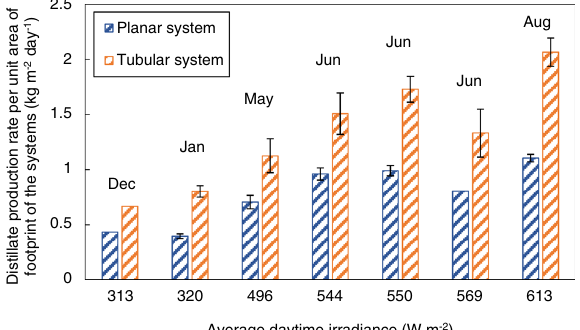
Fig. 4 Distillate production rates of single-stage planar and tubular systems per unit area of footprint under natural sunlight. Both the planar and tubular systems had the same membrane dimensions (i.e., 50 mm × 50 mm), the same volume of distillation chamber, and the same inner surface area of the condensation chamber. The surface density of carbon black NPs on the permeate side of the membrane was 7.5 – 7.9 g m − 2 and the hydrostatic pressure at the center of the membranes during the experiment ranged between 90 and 105 mmH 2 O (i.e., 0.88 and 1.03 kPa), as shown in Supplementary Table 3. Variations of irradiance and weather condition can be found in Supplementary Table 1. The error bars represent the standard deviations of duplicate results obtained using two different systems on the same